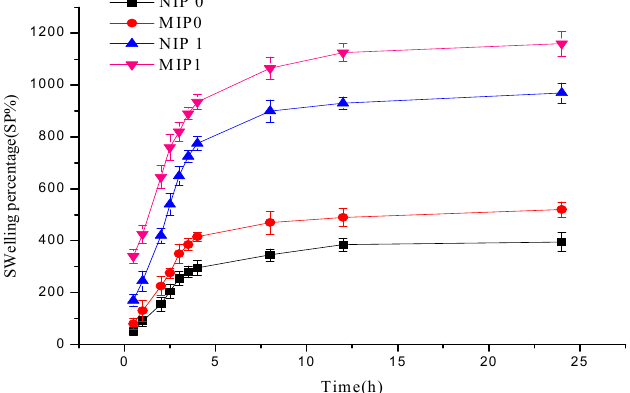
Figure 4. Swelling profiles of MIP0/NIP0 (MAA as monomer) and MIP1/NIP1 (MAA- β -CD as monomer).